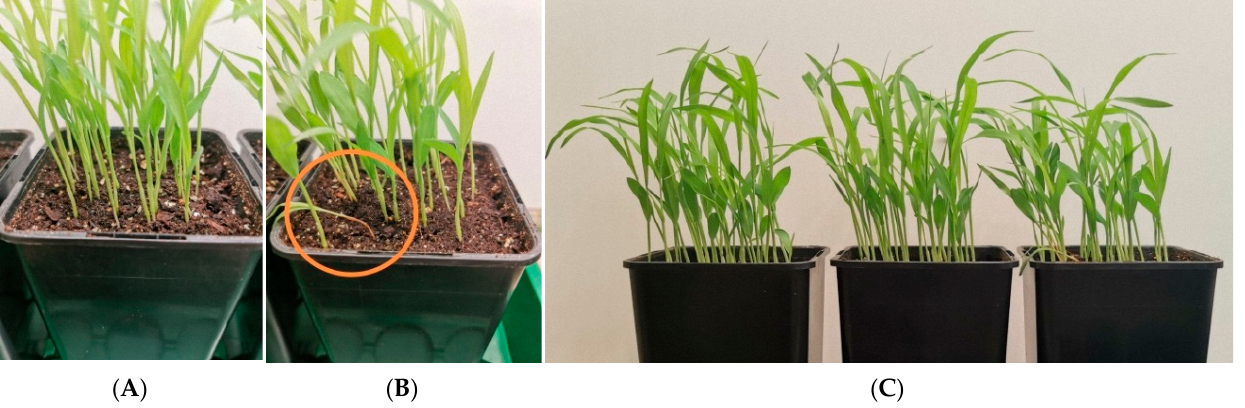
Figure 2. General view of sorghum plants on the 10th day after seed treatment ( A , C ) (pot in the center)—treated with activated water, ( B , C ) (left and right pots)—control. An area of infection and spread of root rot is highlighted around.